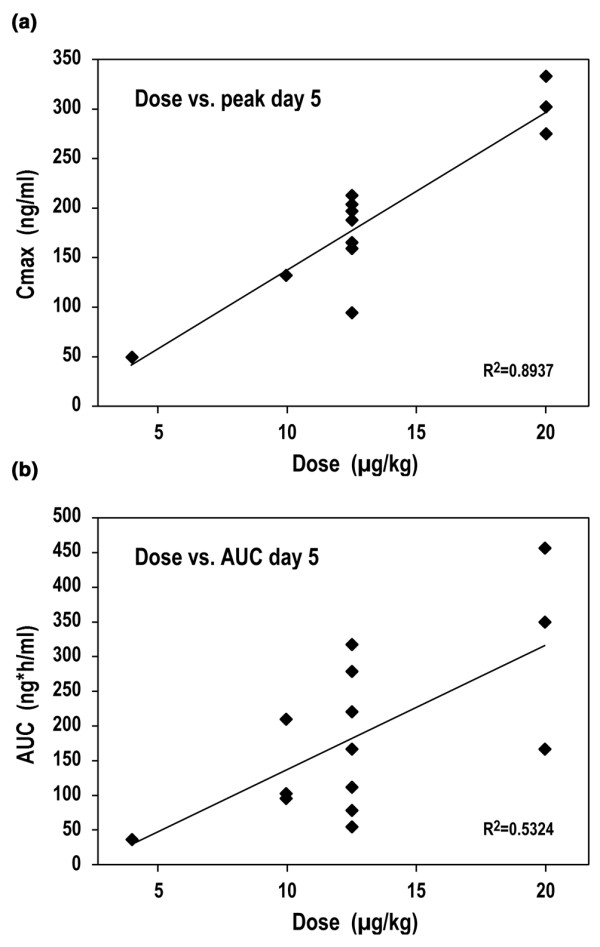
Pharmacokinetic parameters for individual patients on treatment day 5. (a) Dose versus peak plasma concentration, Cmax. (b) Dose versus area under the concentration–time curve (AUC).